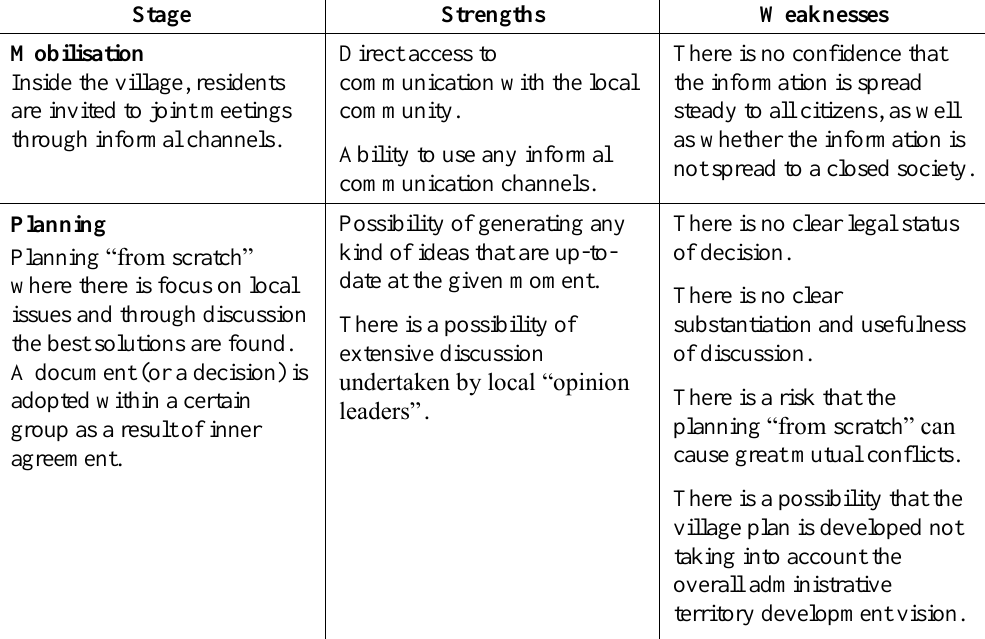
Table 2. Informal Planning Model (developed by the